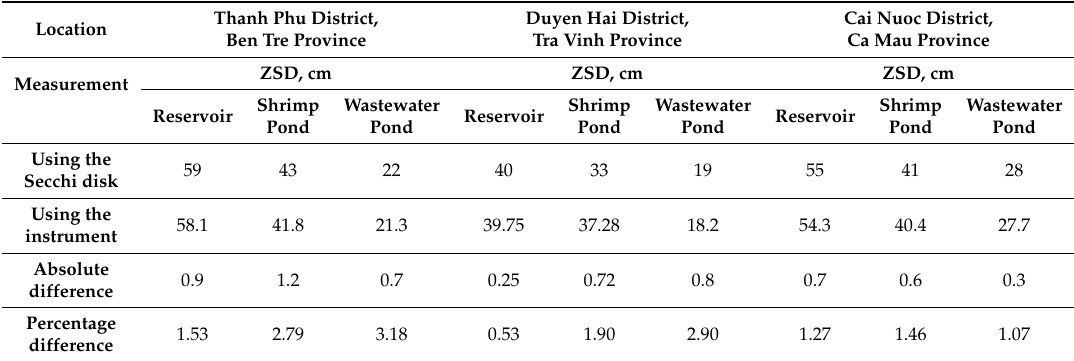
Table 3. Secchi depth measured by Secchi disk and our instrument in Ben Tre, Tra Vinh, and Ca Mau